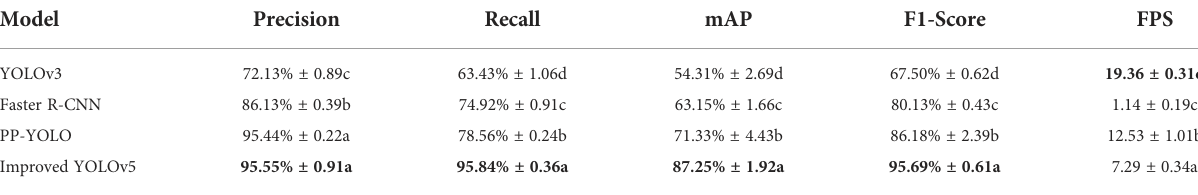
TABLE 3 Comparison of different target detection algorithms.